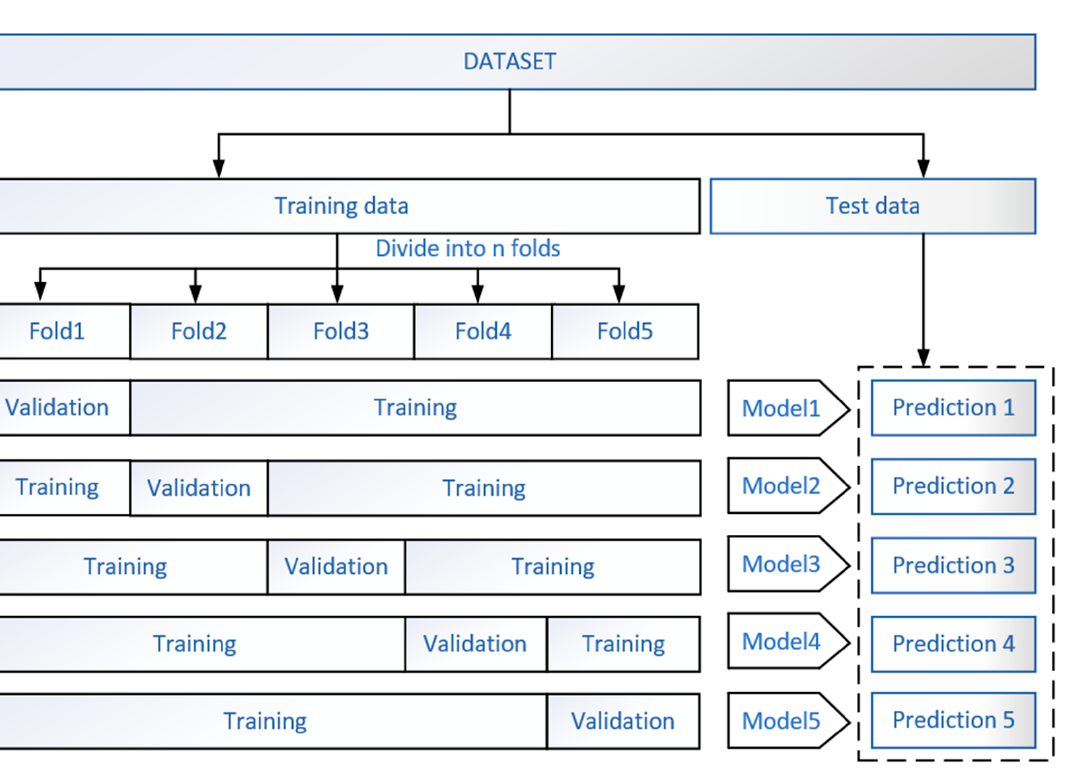
Table 4. Comparison of agricultural image classification models based on state-of-the-art CNN- based and transformer models.